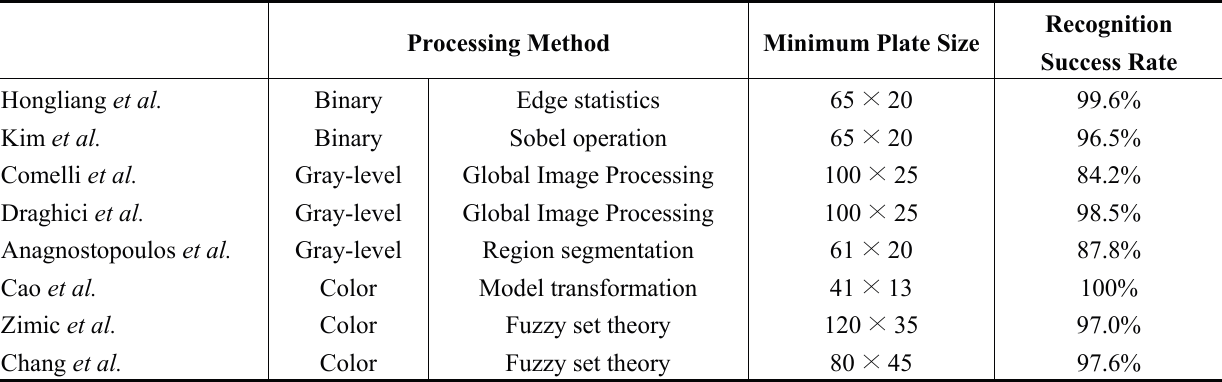
Table 12. Comparison of license plate recognition